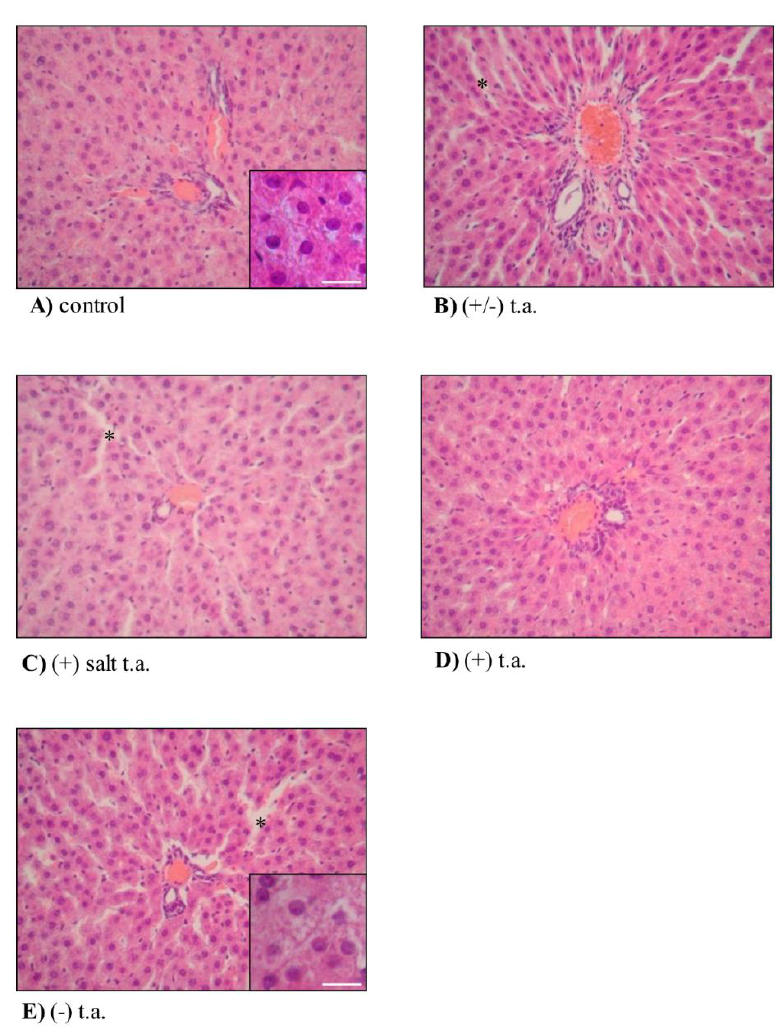
Figure 7. Subchronic toxicity treatments: liver histology. Effects of 15-day subchronic toxicity treatment with 360-µmol/kg thioctic acid isoforms on histological features of liver. Histological analysis was performed on liver samples explanted from rodents treated with ( A ) physiological solution, ( B ) racemic thioctic acid, ( C ) (+) tromethamine salt enantiomer, ( D ) (+) acid enantiomer and ( E ) (−) enantiomer. Asterisks point to morphological changes. Staining with hematoxylin–eosin techniques; original magnification 20×; insert scale bars = 200 µm.